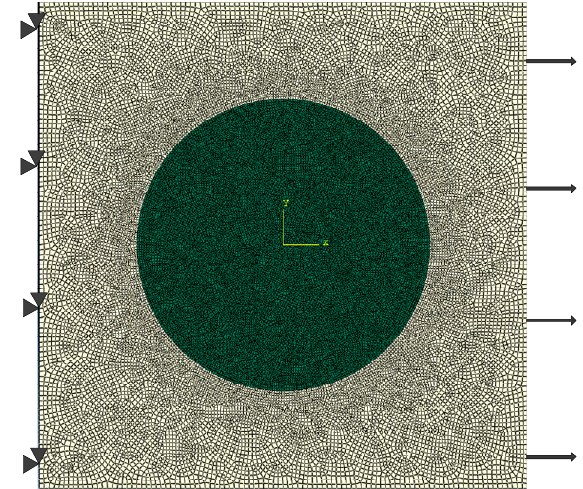
Figure 6. Boundary condition and loading.